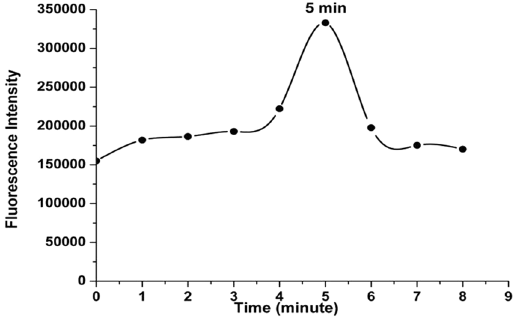
Figure 3. The fluorescence intensity of FITC-added anti-SAG1 IgY antibody against time ( λ ex = 495 nm, λ = 520 nm). em